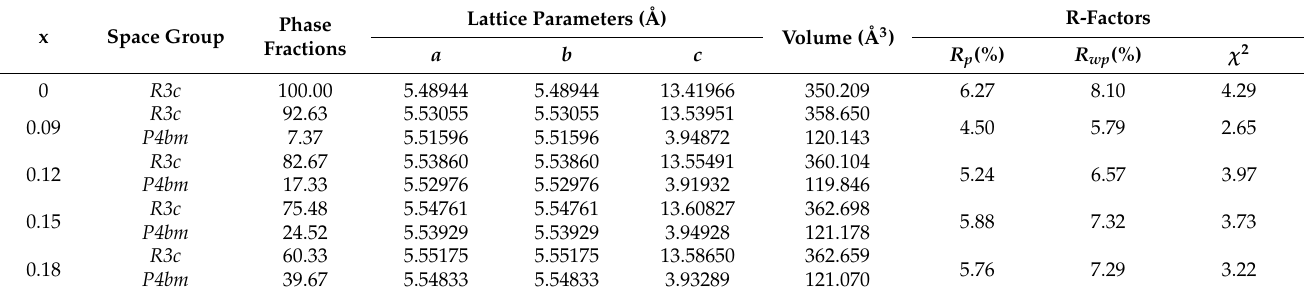
Table 1. The lattice parameters and R-factors obtained using the Rietveld